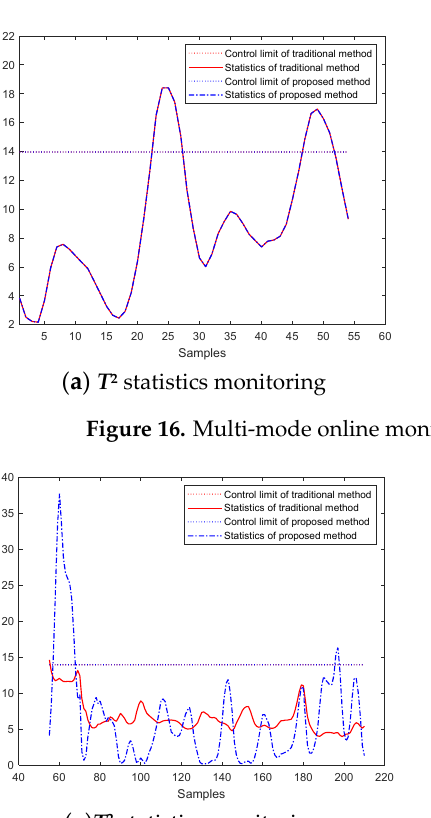
Figure 15. Multi-mode online prediction of mode 1.